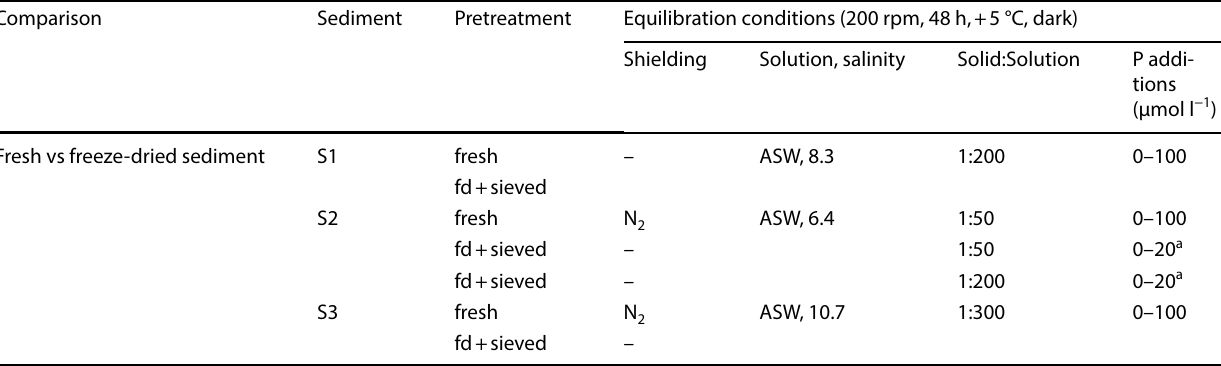
Table 1 Experimental conditions for the comparisons of P exchange of the fresh (treated with or without N sediments (ASW = artificial seawater, fd = freeze-dried, salinity of water determined ca 5 cm above the sediment surface)